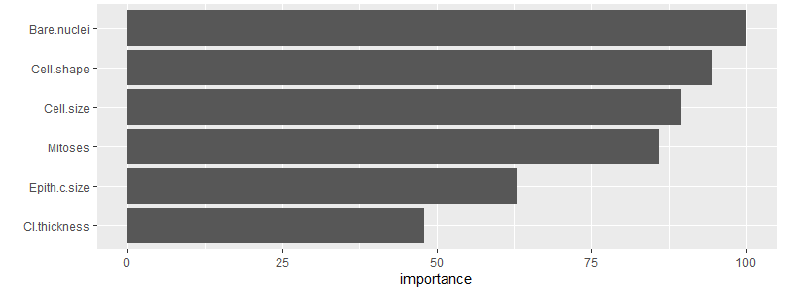
Figure 26. FFNN important variables for the breast cancer